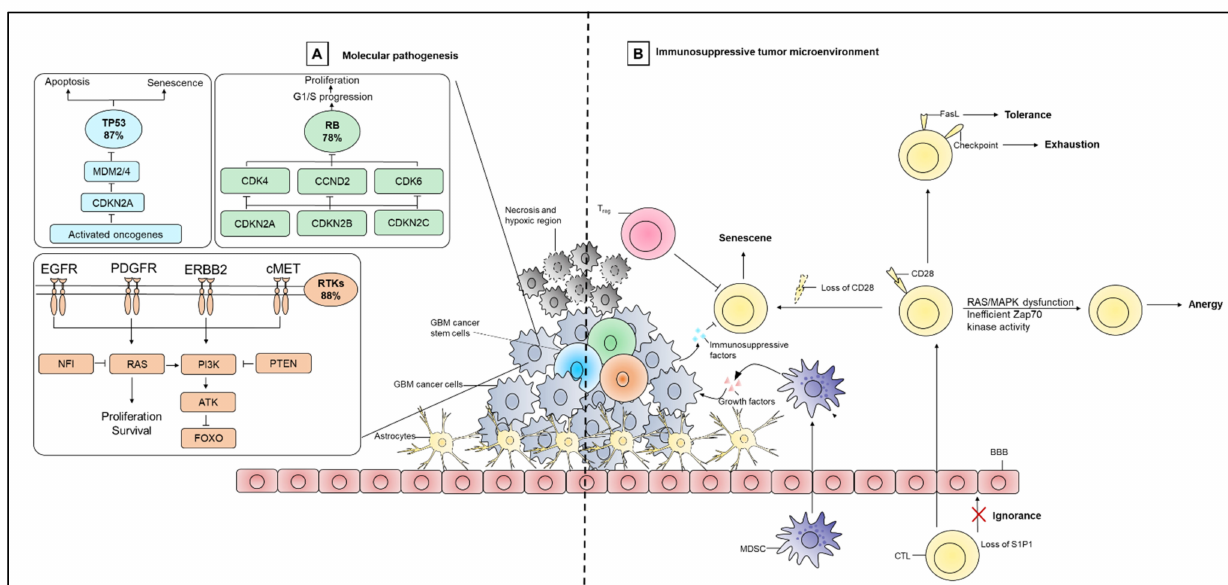
Figure 1. Characteristics of the GBM tumor microenvironment. ( A ) Three dominant molecular alterations in GBM include P53, retinoblastoma (Rb), and receptor tyrosine kinase (RTK) signaling pathways and their corresponding frequencies in GBM. ( B ) The GBM tumor microenvironment (TME) is immunosuppressed mainly due to presence of dysfunctional T cells and myeloid-derived suppressor cells (MDSCs). T cell dysfunction results from different mechanisms that involve senescence, tolerance, anergy, exhaustion, and ignorance. T cells senescence is associated with loss of the co-stimulator CD28, which may occur as a result of telomere damage, presence of Tregs, or TME metabolic stress. Tolerance of T cells is mediated by FasL-induced apoptosis, recruitment of Tregs, and upregulation of factors that limit T cell effector functions. T cell anergy occurs due to RAS/MAPK dysfunction or inefficient Zap70 kinase activity. Co-expression of immune checkpoint molecules such as PD-1, LAG-3 and TIM-3 are also important contributors to T cell exhaustion in GBM. The loss of sphingsosine-1-phosphate receptor 1 (S1P1) is associated with T cell ignorance. MDSCs release immunosuppressive growth factors and other mediators to support growth of cancer cells. Cancer cells can also secret a number of immunosuppressive factors to maintain their overall